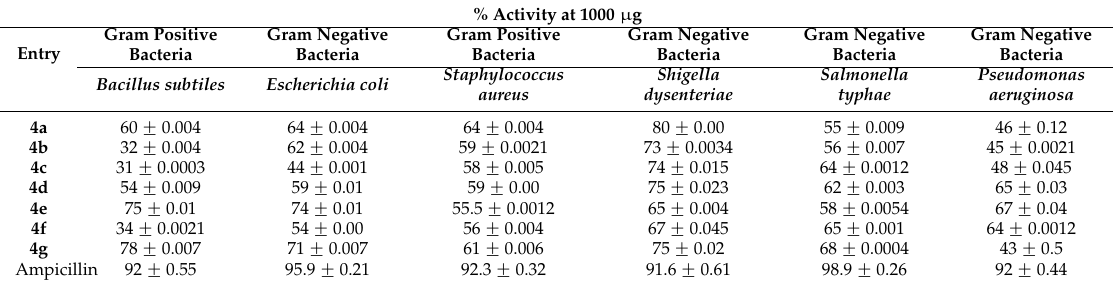
Table 9. Antibacterial activities (1000 µ g) of 5-arylthiophene-2-sulfonylacetamide 4a – g . % Activity at 1000 µ